Question: What visual encoding does this figure use to show its data?
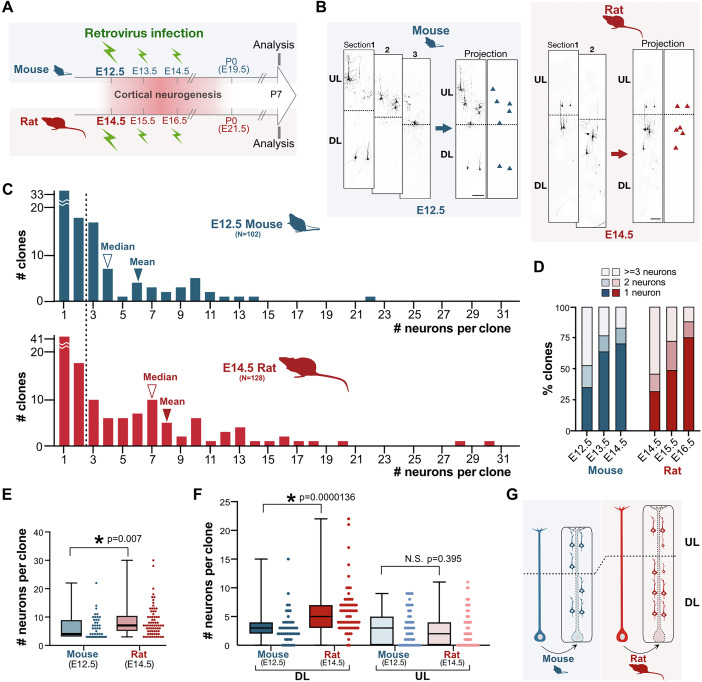
Answer: box